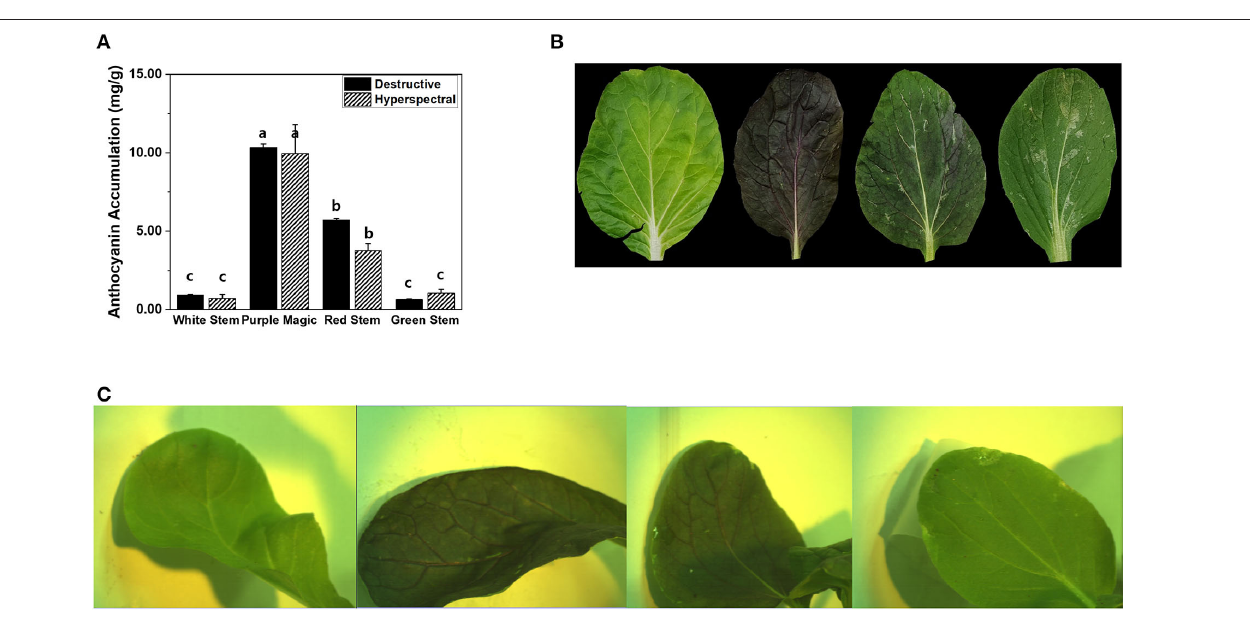
FIGURE 2 | (A) Comparison of anthocyanin accumulations (mg/g DW) obtained by destructive analysis and hyperspectral analysis among targeted leaf of four bok choy cultivars grown under the SC at GS2. These data were obtained from the second experiment described in the Materials and methods section. Means with a different letter are significantly different at P ≦ 0.05, using Fisher’s LSD analysis. (B) The representative image of four different bok choy cultivars (from the left white stem, purple magic, red stem, and green stem). (C) The representative hyperspectral image was taken in leaf-level in four different bok choy cultivars (from the left white stem, purple magic, red stem, and green